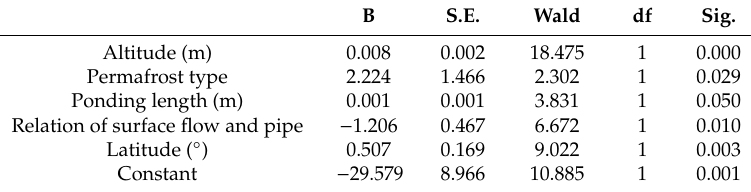
Table 3. Variables in the regression equation for damage caused by frost heave and thawing settlement.